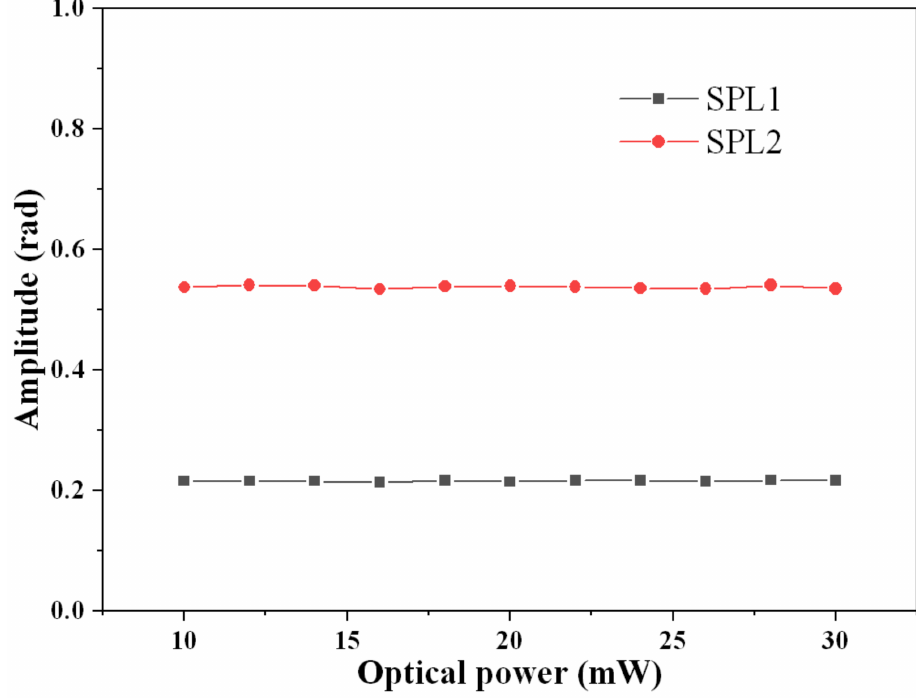
Figure 6. Relationship between optical power and demodulated phase amplitude. SPL1: 67.6 dB, SPL2: 75.6